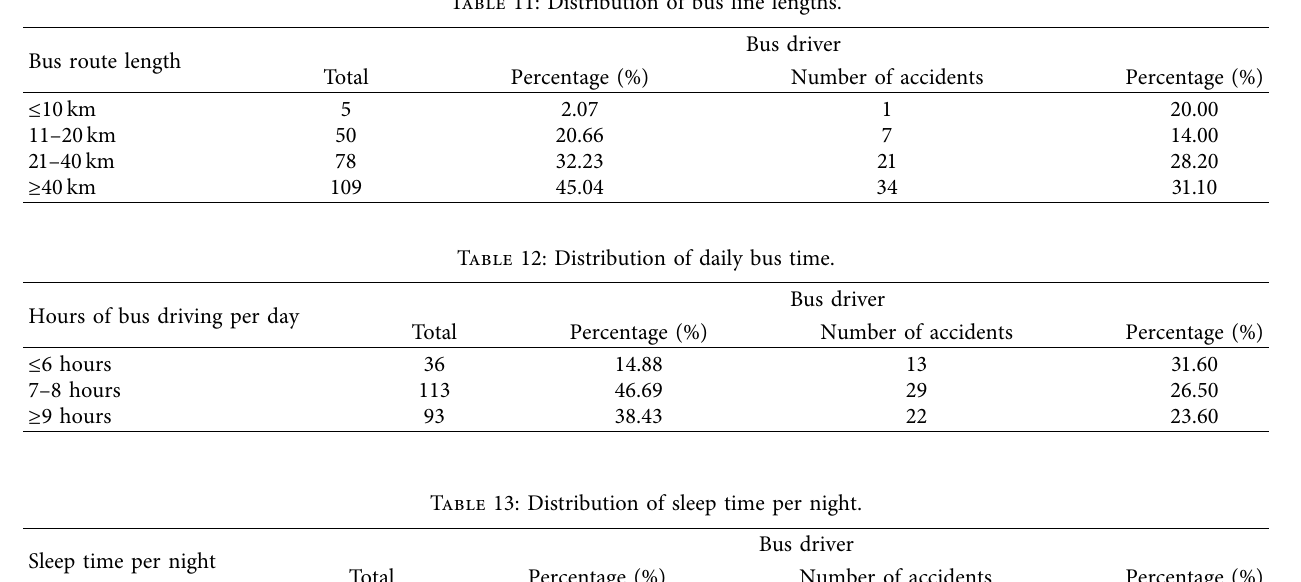
Table 11: Distribution of bus line lengths.